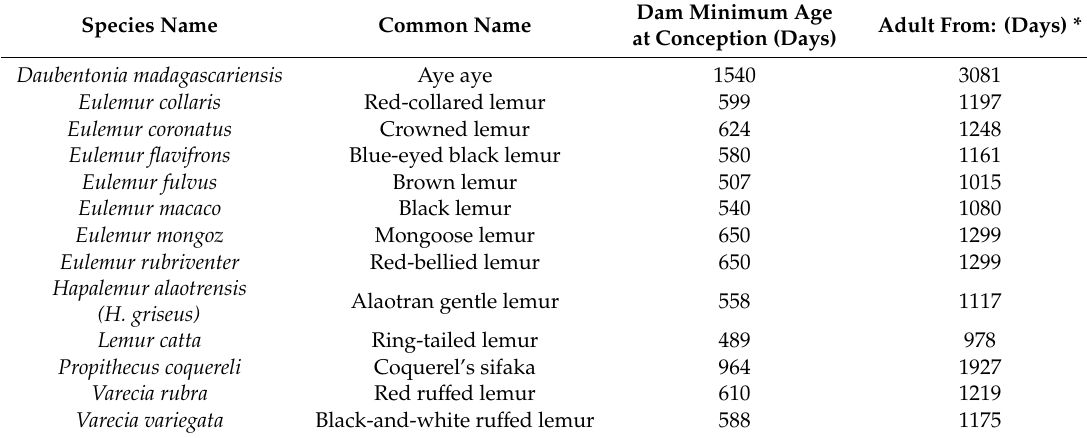
Table A1. Ages from which each species is considered adult (see Section 2.2 for rationale). Values are rounded to the nearest whole